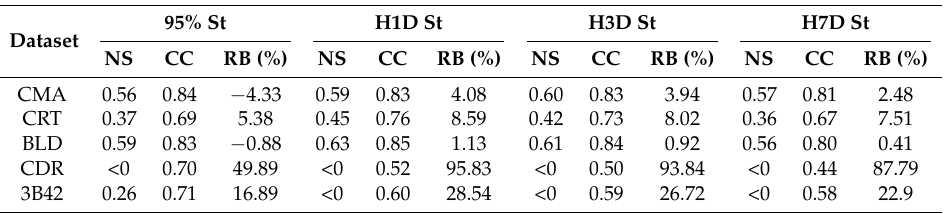
Table 3. The statistical indicators for simulated extreme streamflow forced by CMA data and four SGPEs versus the observed streamflow during 2001–2012.